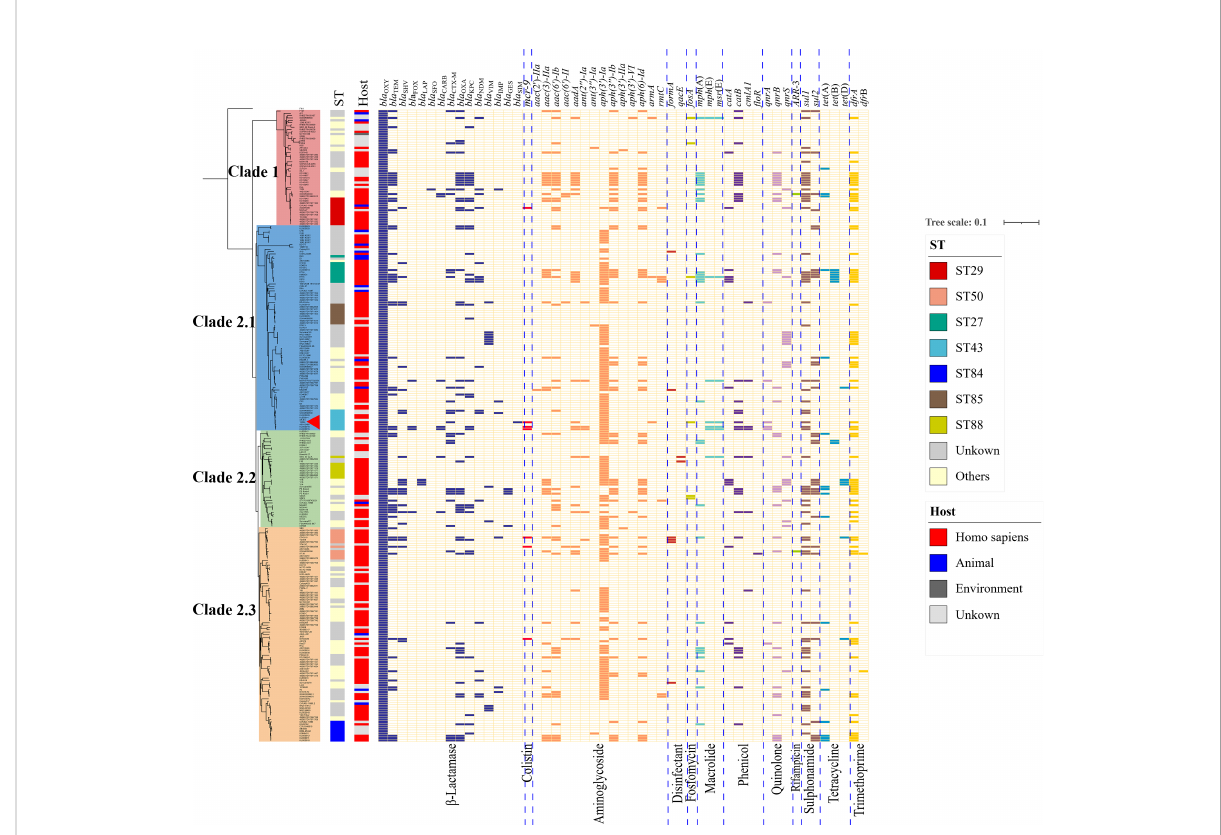
FIGURE 5 The maximum-likelihood tree and ARGs distributions in K. michiganensis . The matrix of ARGs is present for all K. michiganensis genomes against the dendrogram. The top of the matrix indicates the names of ARGs, while the bottom of that represents the groups of ARGs. The colored cells represent the “ presence ” of the ARGs, and the cells are colored based on the groups of ARGs. The strain 12084 is marked with a red